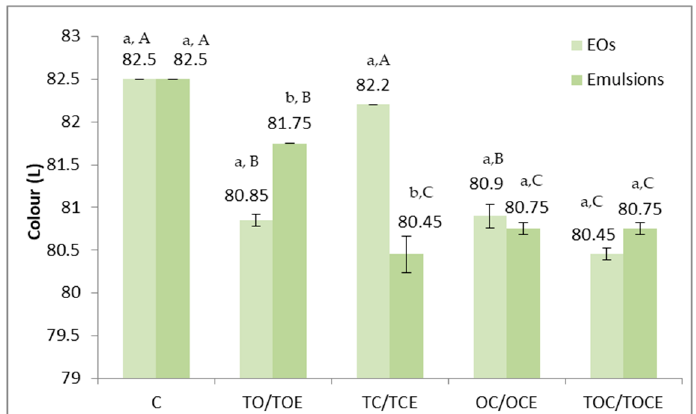
Figure 6. Colour parameters of wheat seeds contaminated with DON, before and after treatment with binary and tertiary mixtures of EOs and natural preparations. C—control; OC—binary mixture of oregano and coriander EO; OCE—binary emulsion of oregano and coriander EOs; TO—binary mixture of thyme and oregano EOs; TOE—binary emulsion of thyme and oregano EOs; TC—binary mixture of thyme and coriander EOs; TCE—binary emulsion of thyme and coriander EOs; TOC— tertiary mixture of oregano, coriander, and thyme EOs; TOCE—tertiary emulsion of oregano, coriander, and thyme EOs. The values are expressed as mean values ± standard deviations of all measurements. Different superscripts a,b between EOs and emulsions for the same binary or tertiary mixture represent significantly different values ( p < 0.05) according to the t ‐ test; different superscripts A–C between all types of EOs concerned and between all types of emulsions represent significantly different values ( p < 0.05) according to the t ‐ test.